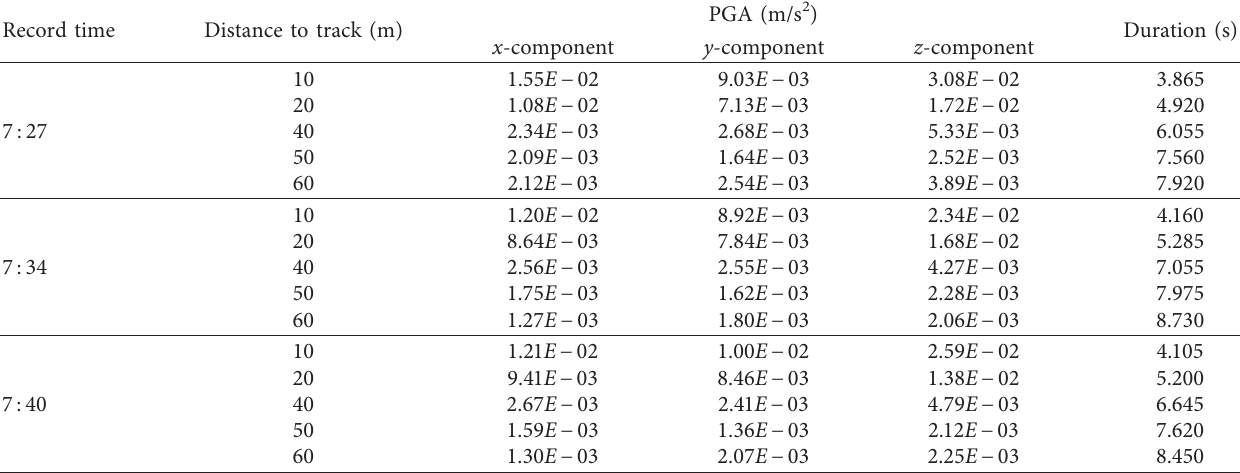
Figure 7: Variation of duration with distance to the track. Table 3: Durations and PGAs of vibrations recorded at all 5